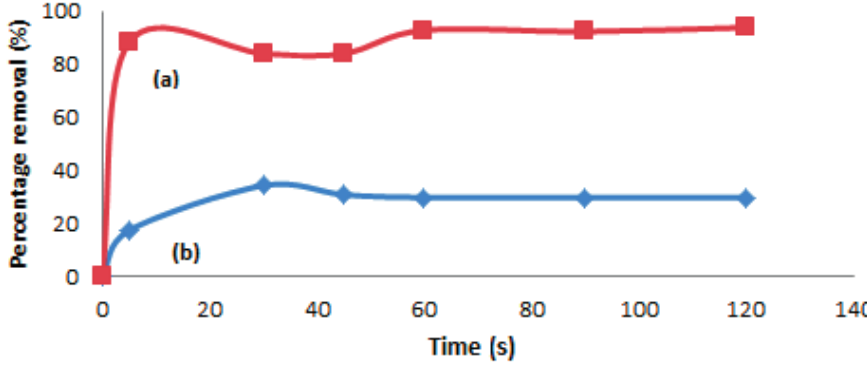
Figure 10. Comparison of the sorption capacities for (a) sludge and (b) crude oil